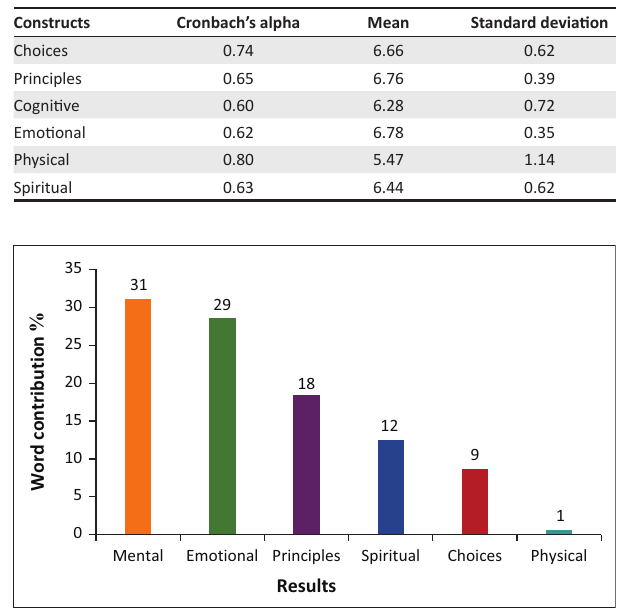
FIGURE 3 : Construct distribution results.